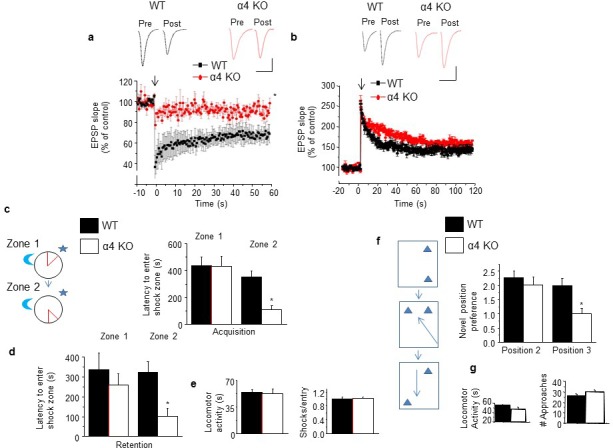
Induction of long-term depression and re-learning are impaired under conditions of high spine density in the α4 KO mouse.(a) Induction of long-term depression (LTD) using low frequency stimulation (arrow). WT, black, α4 KO, red. *t-test, t(6)=3.56, p=0.01, power=0.84; n=4/group. (Figure 5—source data 1) Inset, representative field EPSPs. Scale, 0.2 mV, 20 ms. (b) Induction of long-term potentiation (LTP) using theta burst stimulation (arrow). WT, black, α4 KO, red. t-test, t(7)=0.28, p=0.78; n=4–5/group. (Figure 5—source data 2) Inset, representative field EPSPs. Scale, 0.2 mV, 25 ms. (c) [Inset, The active place avoidance task (APA). The animal is trained to avoid a shock zone (red) on a rotating arena. Day 1, training for zone 1; day 2, training for zone 2.] Average latency to enter shock zone 1 (Z1) and 2 (Z2), Acquisition. *t-test, Zone 1, t(9)=0.02, p=0.99; Zone 2, t(10)=3.37, p=0.007*, power=0.86; n=5–7 mice. (d) Average latency to enter shock zone 1 (Z1) and 2 (Z2), Retention. * t-test, Zone 1, t(9)=1.17, p=0.27; Zone 2, t(10)=3.08, p=0.012*, power=0.80; n=5–7 mice. (Figure 5—source data 3) (e) Locomotor activity (left, t test, t(10)=0.67, p=0.52) and # shocks/entry, a measure of escape behavior (right, t test, t(10)=0.08, p=0.93). n=5–7 mice/group. (Figure 5—source data 4) (f) Inset, the multiple placement object recognition task (MPORT). Sequence of positions (1–3) of object 2 across 3 training trials. Novel position preference for positions 2 and 3. Position 2, *t-test, t(23)=0.85, p=0.40; Position 3, t(23)=4.61, p<0.0001*, power=1; WT, n=15 mice; α4 KO, n=10 mice. (Figure 5—source data 5) (g) Locomotor activity (left, t-test, t(23)=0.34, p=0.74; WT, n=15 mice; α4 KO, n=10 mice) and # approaches, a measure of object interest (right, t t-test, t(23)=0.97, p=0.339; WT, n=15 mice; α4 KO, n=10 mice) (Figure 5—source data 6). Effects on MK-801 and memantine on learning and re-learning are depicted in Figure 5—figure supplement 1. Picrotoxin effects on learning and re-learning are depicted in Figure 5—figure supplement 2.DOI:
http://dx.doi.org/10.7554/eLife.15106.02710.7554/eLife.15106.028Figure 5—source data 1.Figure 5a: Percent baseline slope of field EPSPs recorded after low frequency (1 Hz) stimulation to induce LTD for post-pubertal WT and α4 KO CA1 hippocampus (120 min, 30 s intervals).Each column is a separate slice recording.DOI:
http://dx.doi.org/10.7554/eLife.15106.02810.7554/eLife.15106.029Figure 5—source data 2.Figure 5b: Left, Percent baseline slope of field EPSPs recorded after theta burst stimulation to induce LTP for post-pubertal WT and α4 KO CA1 hippocampus (final 20 min 100 min after LTP induction, 30 s intervals).Each column is a separate slice recording. Right, Averaged values for the final 20 min. segment.DOI:
http://dx.doi.org/10.7554/eLife.15106.02910.7554/eLife.15106.030Figure 5—source data 3.Figure 5c: Learning acquisition (left) and retention (right) for zone 1 of the active place avoidance task (APA).Latency to enter shock zone (s) for post-pub WT and α4 KO mice. Figure 5d, Re-learning acquisition (left) and retention (right) for zone 2 of the APA. Latency to enter shock zone (s) for post-pub WT and α4 KO mice.DOI:
http://dx.doi.org/10.7554/eLife.15106.03010.7554/eLife.15106.031Figure 5—source data 4.Figure 5e: #shocks/entry (left) and locomotor activity (right) for post-pub WT and α4 KO mice assessed for the active place avoidance task (APA).DOI:
http://dx.doi.org/10.7554/eLife.15106.03110.7554/eLife.15106.032Figure 5—source data 5.Figure 5f: Learning acquisition for zones 1–3 for post-pub WT (left) and α4 KO (right) of the multiple placement object relocation task (MPORT).Duration of time spent, M, moved object; unm, unmoved object; m/unm, ratio of time spent moved versus unmoved object.DOI:
http://dx.doi.org/10.7554/eLife.15106.03210.7554/eLife.15106.033Figure 5—source data 6.Figure 5g: Locomotor activity (left) and # approached, a measure of interest (right) for for post-pub WT (left) and α4 KO (right) mice using MPORT.